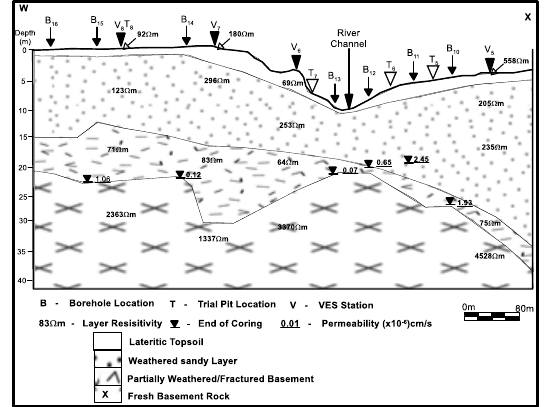
Figure 4: Lithological Section along Dam Axis B